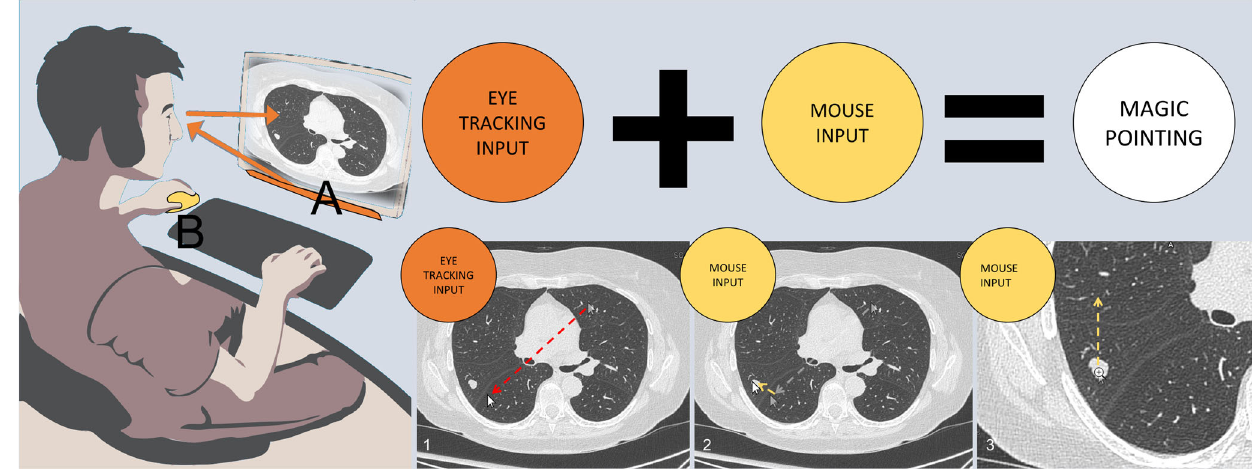
Fig. 4 Potential use of manual and gaze input cascaded (MAGIC) pointing for diagnostic radiology. The radiologist is examining lung parenchyma. When he focuses on an anomaly, the eye tracking device automatically moves the pointer around the region of interest. A large